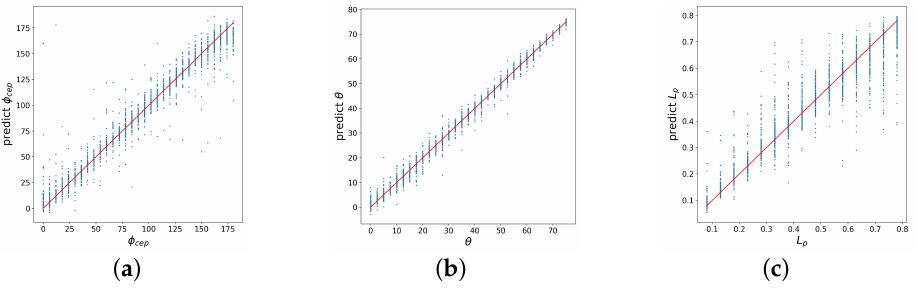
Figure 2. Correlation of the exact and predicted values of laser–plasma interaction parameters, reconstructed by a baseline fully connected NN trained on a clean data: ( a ) carrier envelope phase, ( b ) incidence angle, ( c ) pre-plasma